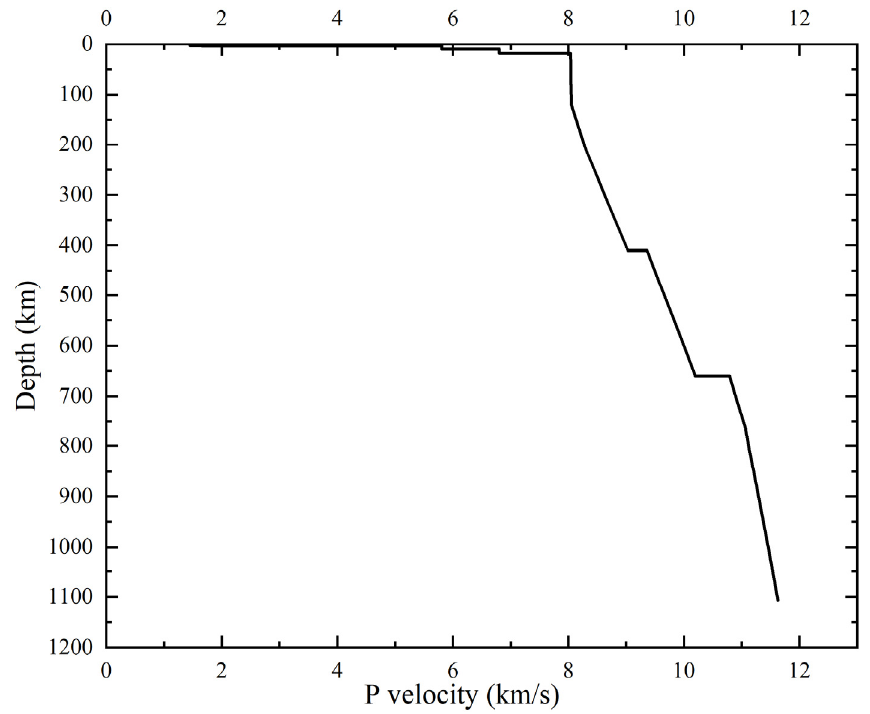
Figure 4. Initial 1-D velocity model used in computation: ak135 [30].